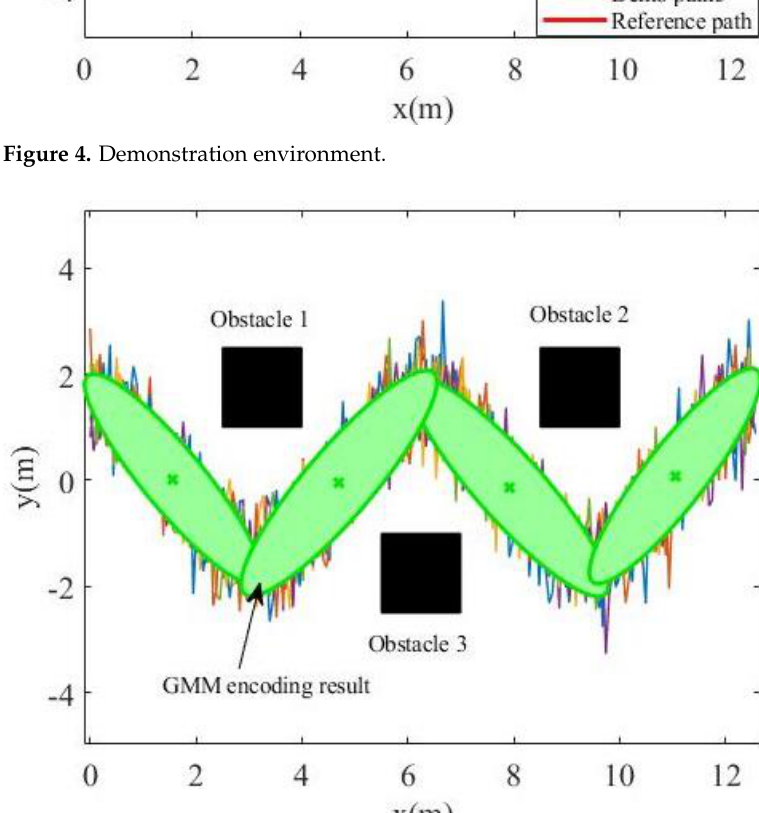
Figure 5. GMM encoding